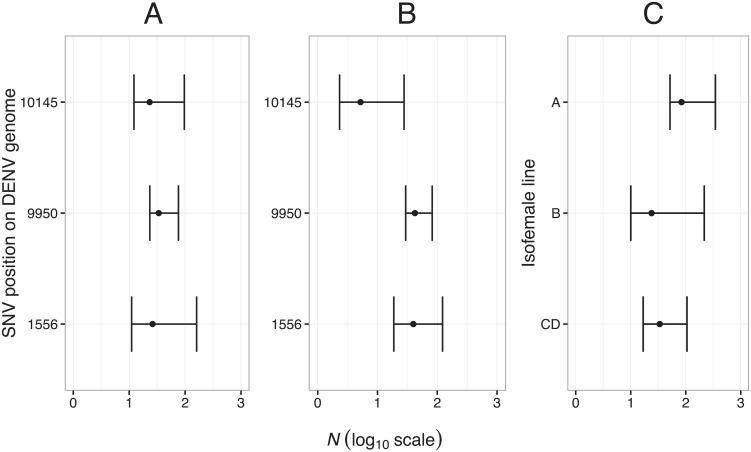
Estimates of bottleneck size at initial midgut infection.The estimated number of founding genomes (N) that contribute to initial midgut infection is shown for three markers identified by their position on the DENV genome (1556, 9950, 10145). The three markers are SNVs that are assumed to evolve neutrally or quasi-neutrally. Horizontal bars indicate confidence intervals of N estimates computed by bootstrapping. (A) N estimates based on samples collected at 4 dpe. (B) N estimates based on samples collected at 7 dpe. (C) N estimates for each isofemale line obtained for marker 1556 using combined 4 dpe and 7 dpe samples.